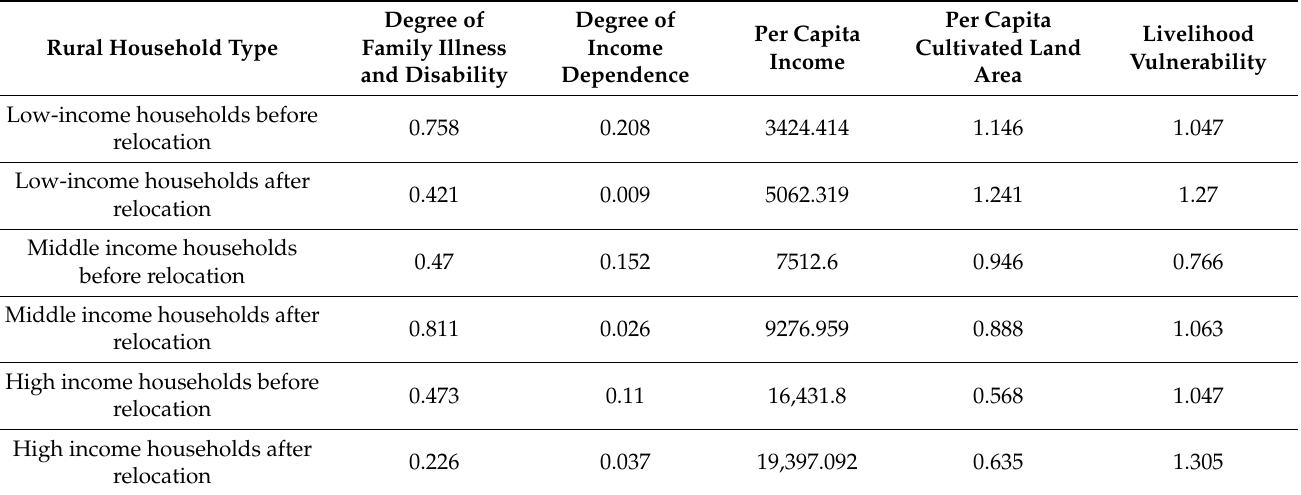
Table 4. Basic information of rural household characteristics before and after